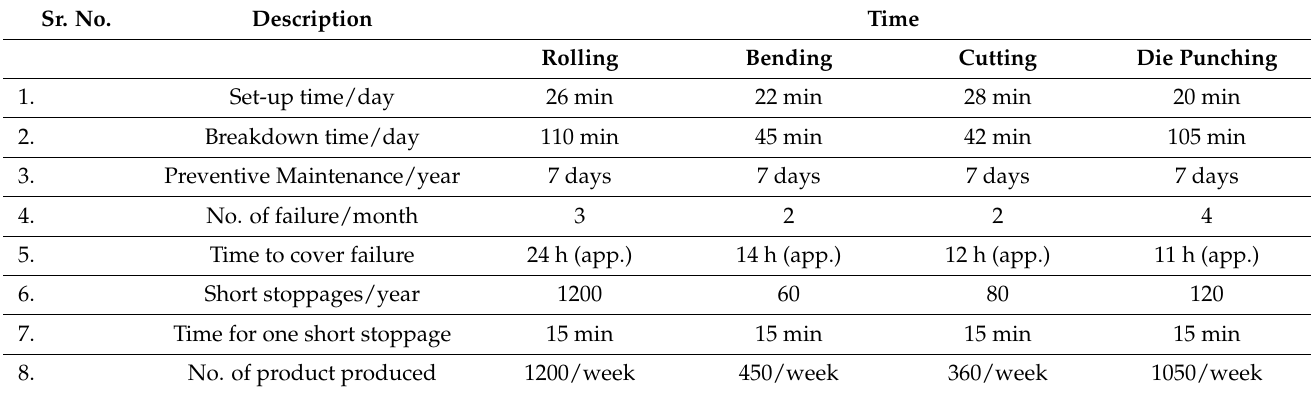
Table 1. Data used for OEE evaluation (before TPM